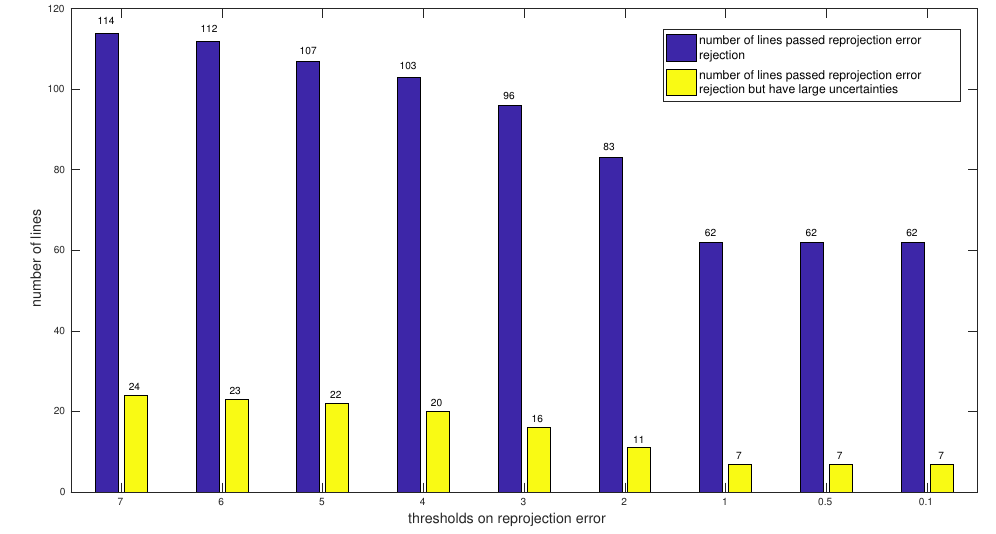
Figure 12. The number of lines passed reprojection error rejection and the number of lines passed reprojection error rejection but have large uncertainties at different reprojection error